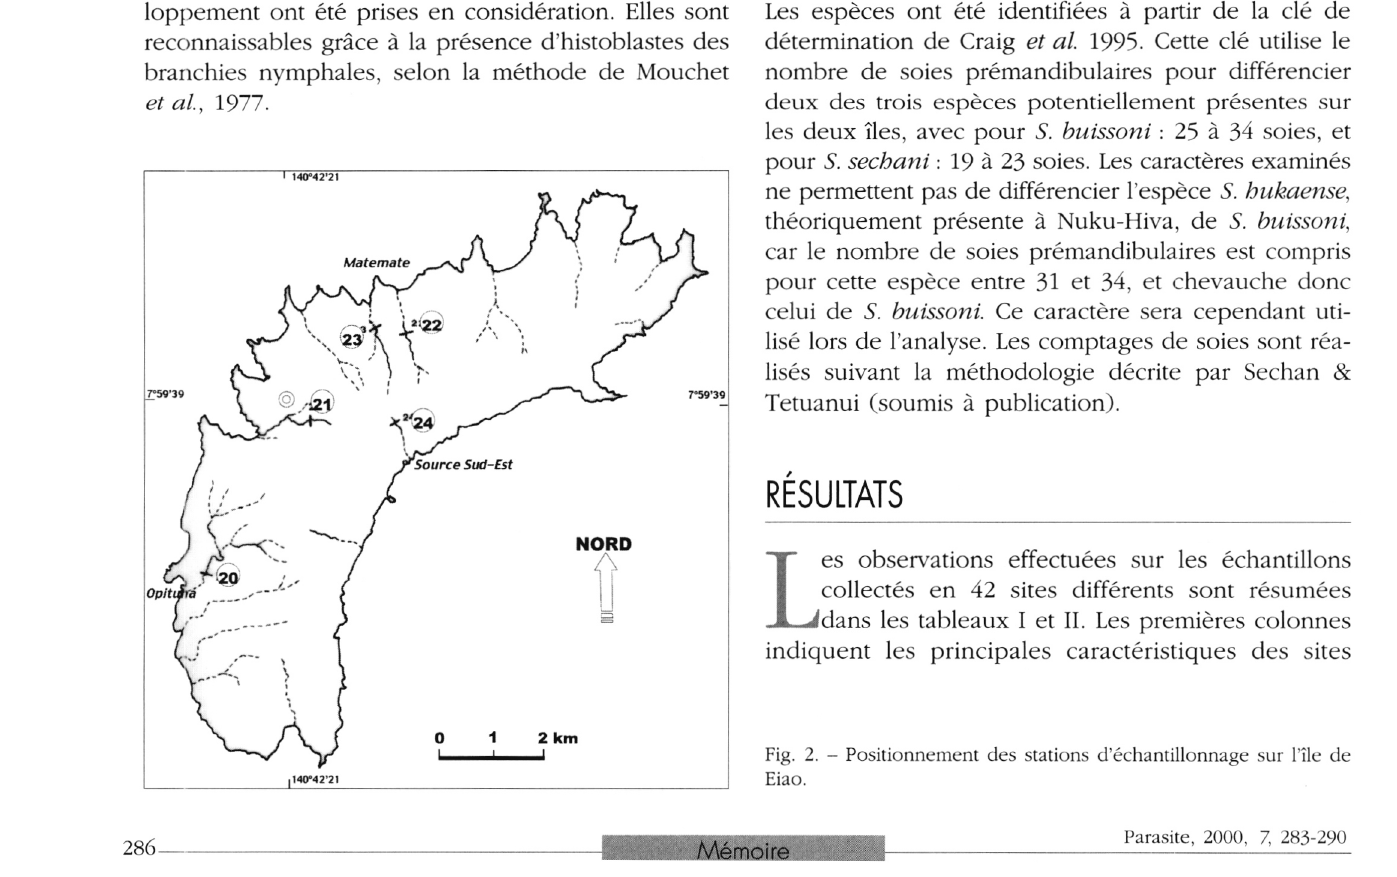
loppement ont été prises en considération. Elles sont reconnaissables grâce à la présence d’histoblastes des branchies nymphales, selon la méthode de Mouchet et al., 1977.